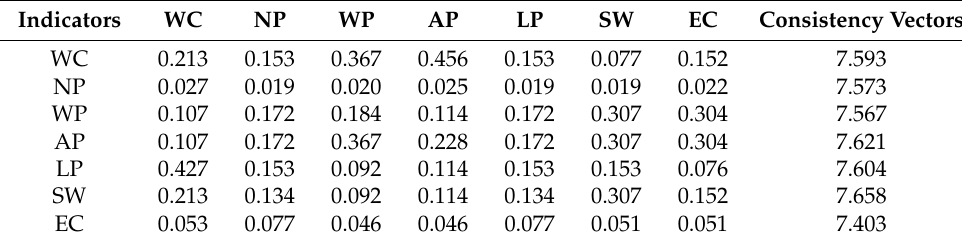
Table 6. Pairwise comparison matrix of the indicators and consistency vectors.